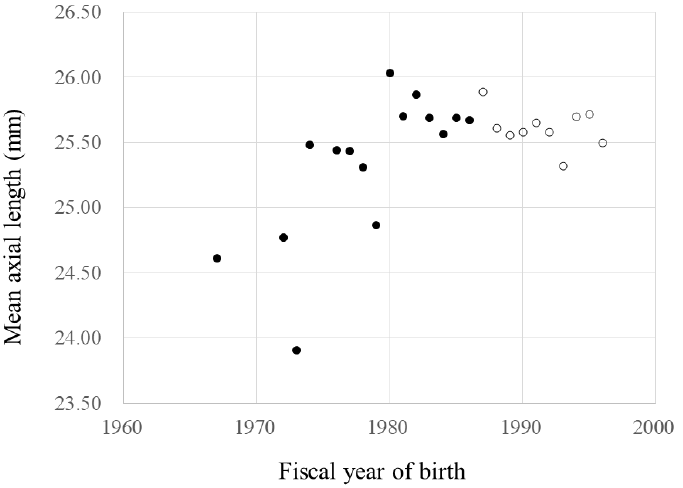
Figure 4. The fiscal year (FY) of birth and mean axial length. ● , data during the FYs of birth before 1987. ○ , data during the FYs of birth of 1987 and after. During the FYs of birth before 1987, y = − 78.9 + 0.0527x, r = 0.157, p = 0.034. During the FYs of birth of 1987 and after, p = 0.599. The regression of spherical equivalent by FYs of birth before 1987 and after, p = 0.004 (ANCOVA).